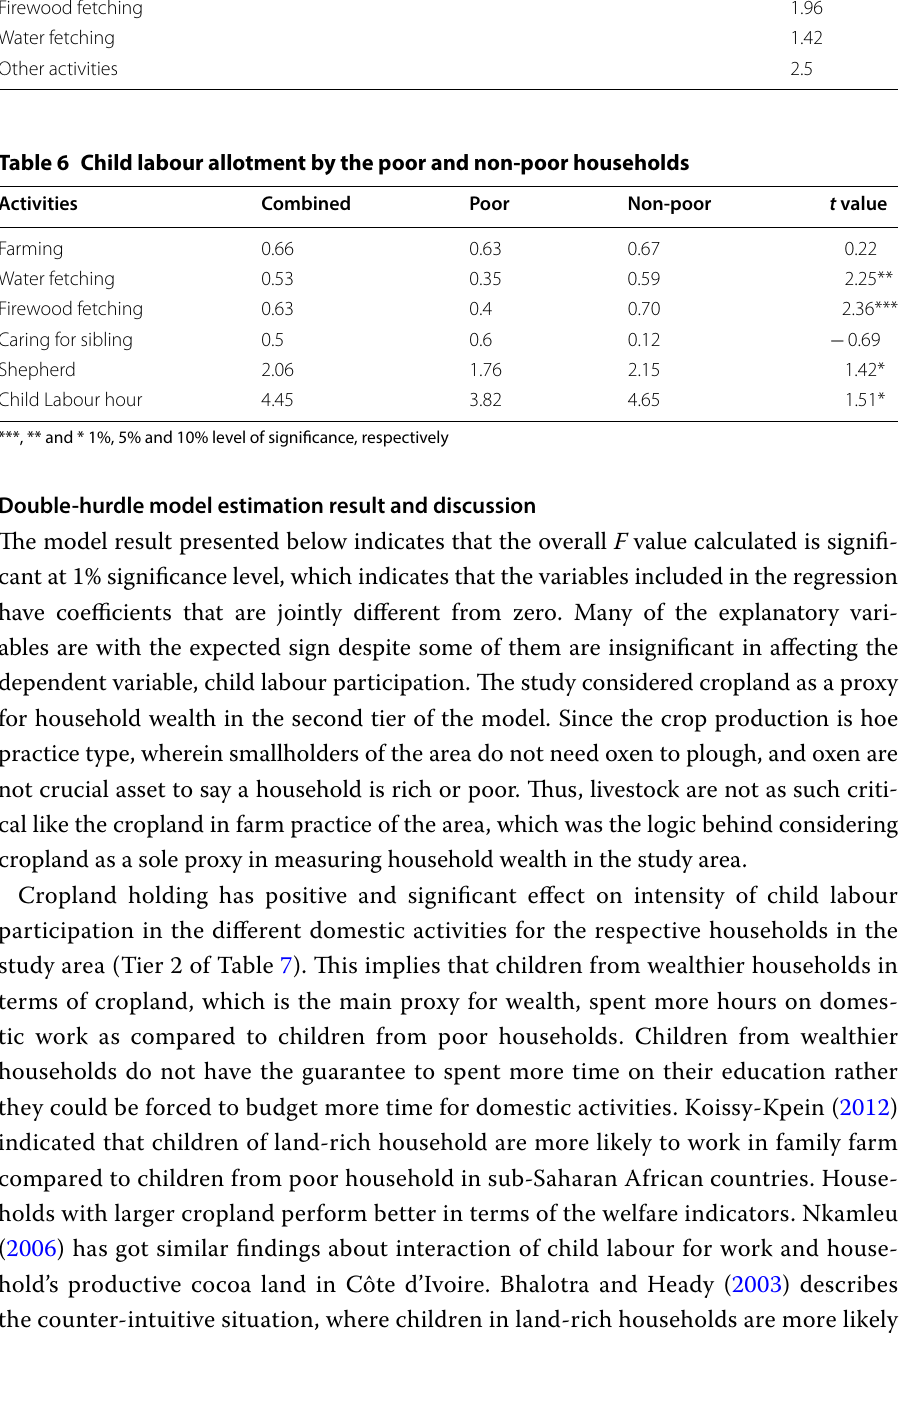
Table 6 Child labour allotment by the poor and non-poor households